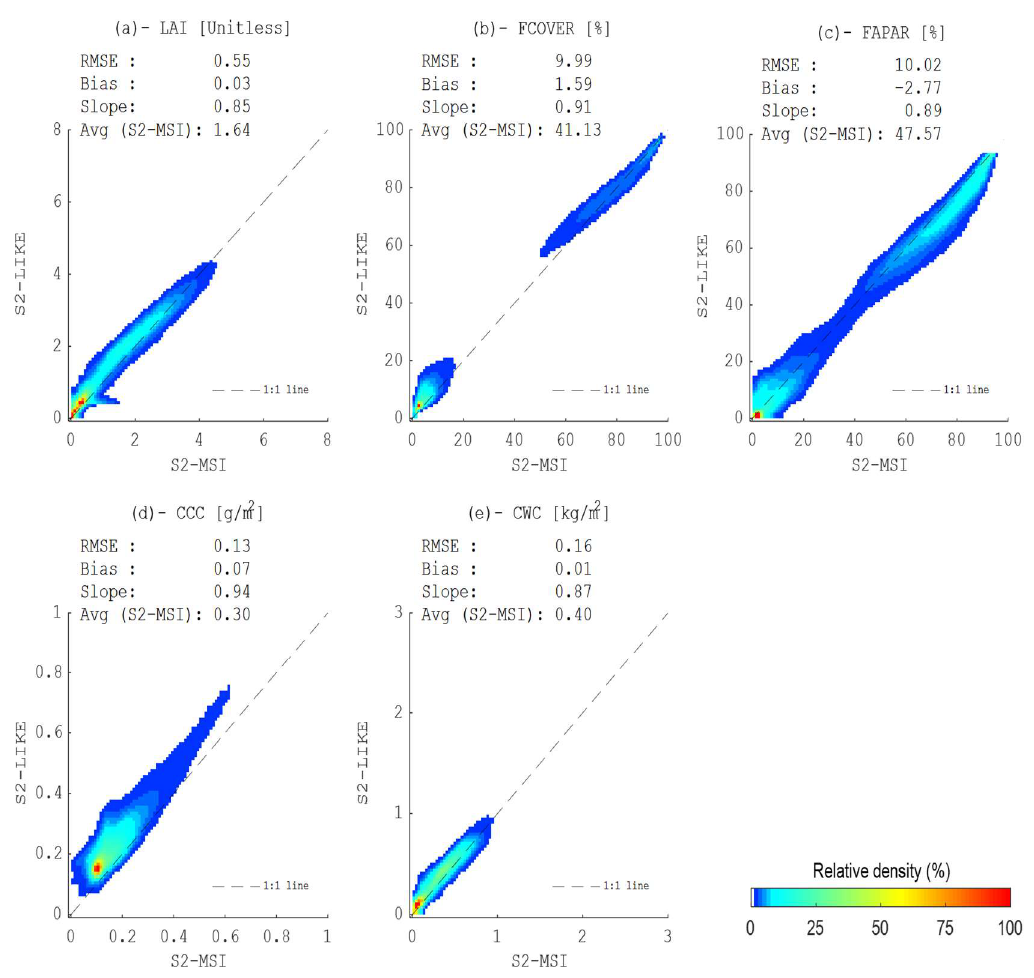
Figure5. VegetationbiophysicalvariablesderivedfromS2-LIKEproductcomparedtothecorresponding Figure 5. Vegetation biophysical variables derived from S2-LIKE product compared to the vegetation biophysical variables derived from S2-MSI (# ~11 × 10 7 corresponding vegetation biophysical variables derived from S2-MSI (# ~11 × 10 7 samples).